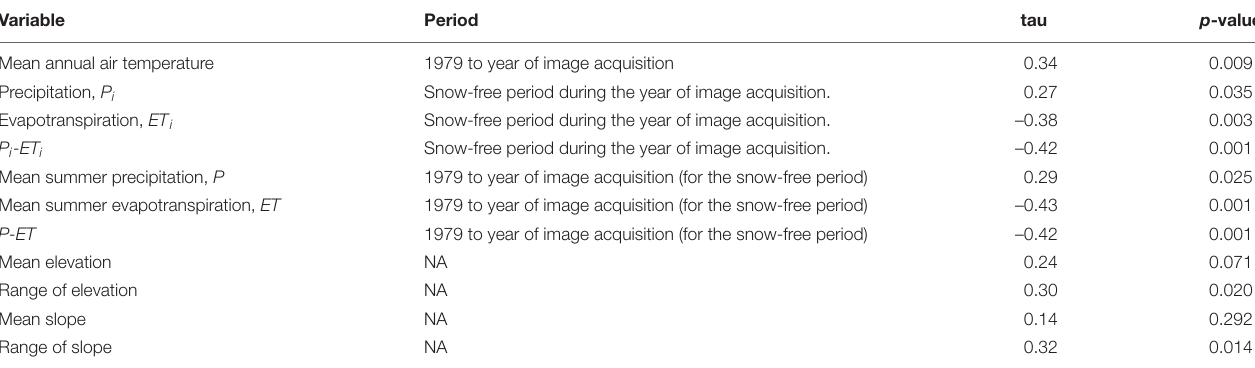
TABLE 3 | Correlation matrix of mean waterbody size versus environmental